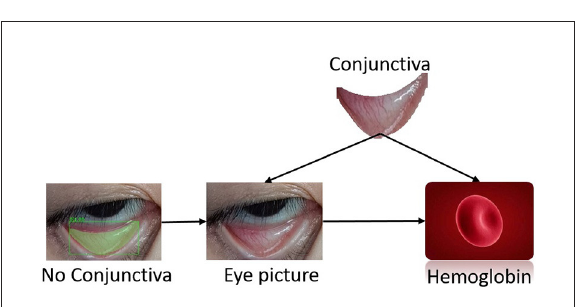
FIGURE2 Cause-and-effect diagram of patient’s Hb